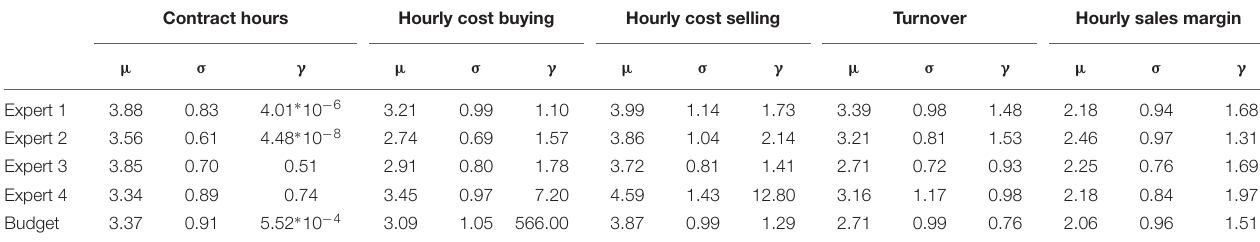
TABLE 2 | Illustration of linear transformations using Eq. 2. Steps 1 and 2 product scale mean result ( n =